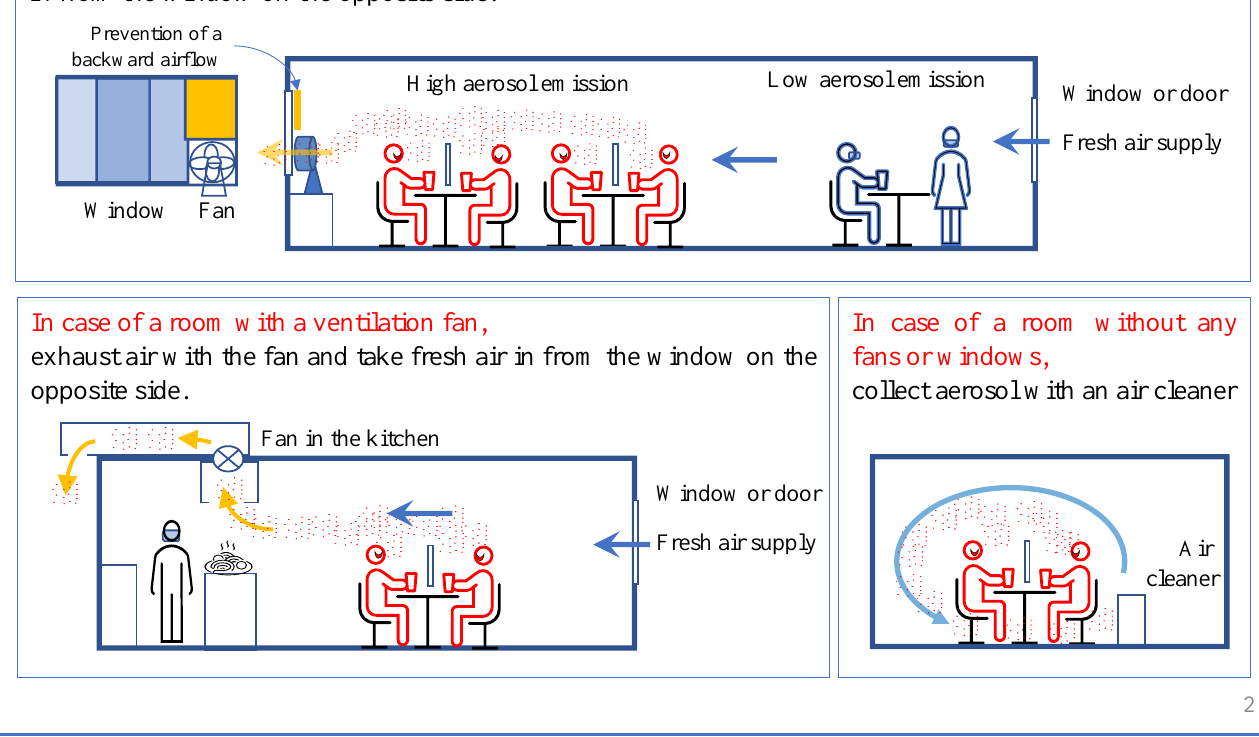
Figure 9. Effective ventilation methods against two aerosol infection types.